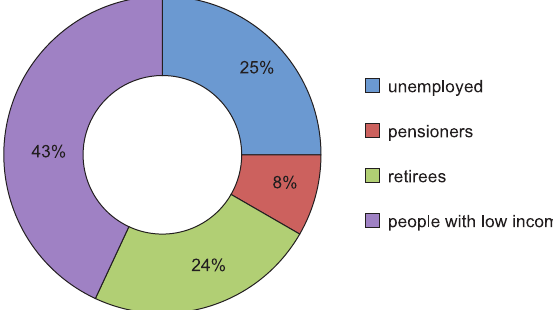
Fig. 7. Economic structure of plots holders in